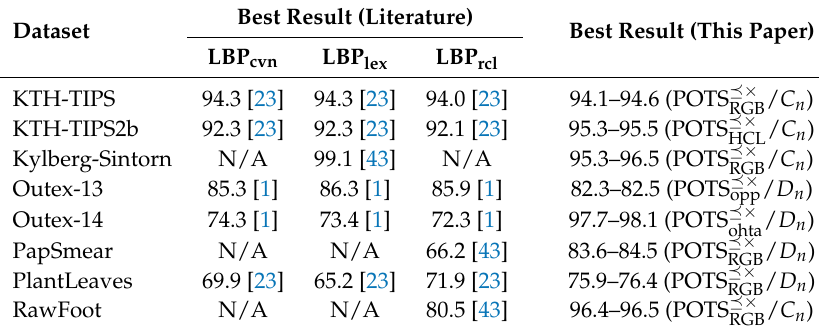
Table 3. Comparison with the results obtained by other ordering methods as reported in the references indicated. Key to symbols: ‘cvn’ = colour vector norm, ‘lex’ = lexicographic ordering, ‘rcl’ = preorder based on white as reference colour. Please refer to the cited works for further